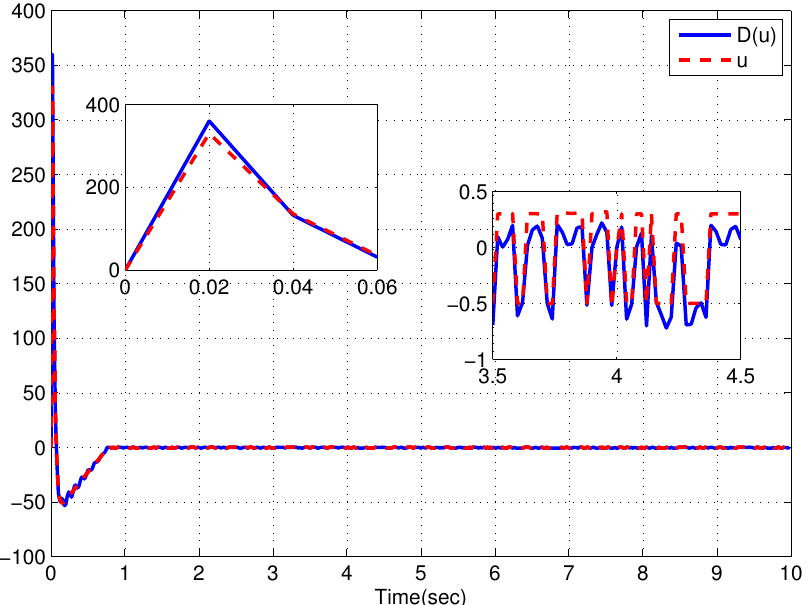
Figure 7. The input responses of the CLS with external disturbance and initial condition ( z ( 0 ) , z ( 0 )) = ( − 1,5 ) 2 1